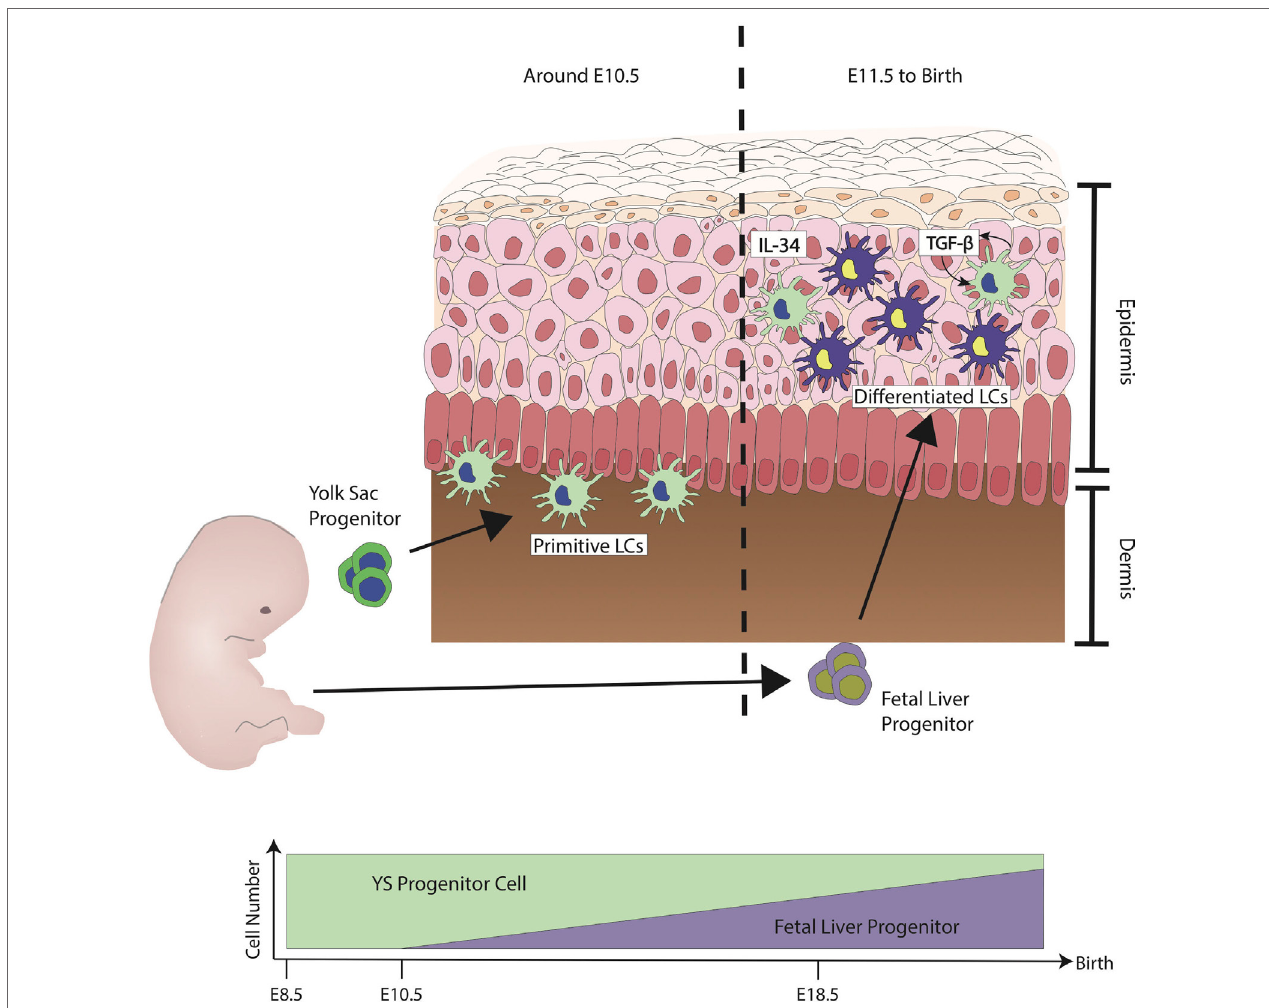
FiGURe 1 | Ontogeny of Langerhans cells (LCs) during steady state. The first wave of LCs that reside in the skin are from the yolk sac (YS) progenitors (green). They populate the skin but are unable to mature fully. At embryonic stage, LCs are immature due to the lack of signals from keratinocytes such as interleukin-34 (IL-34) and transforming growth factor- β (TGF- β ). LCs have shown to have the capability to produce TGF- β . TGF- β derived from LCs acts directly on LCs through the autocrine/paracrine signaling pathway. At around E11.5, fetal liver progenitors (purple) start to populate the skin and, similar to the YS progenitors, they are still immature and sparsely distributed. Differentiation into LC has been observed from E18.5 onward, at the same time when keratinocytes start to fully differentiate. Upon birth, LCs have been observed to proliferate to form LC network. During steady state, LCs maintain their network by the low level of proliferation without much contribution from monocytes derived from the bone marrow. Figure adapted from Ginhoux et al.